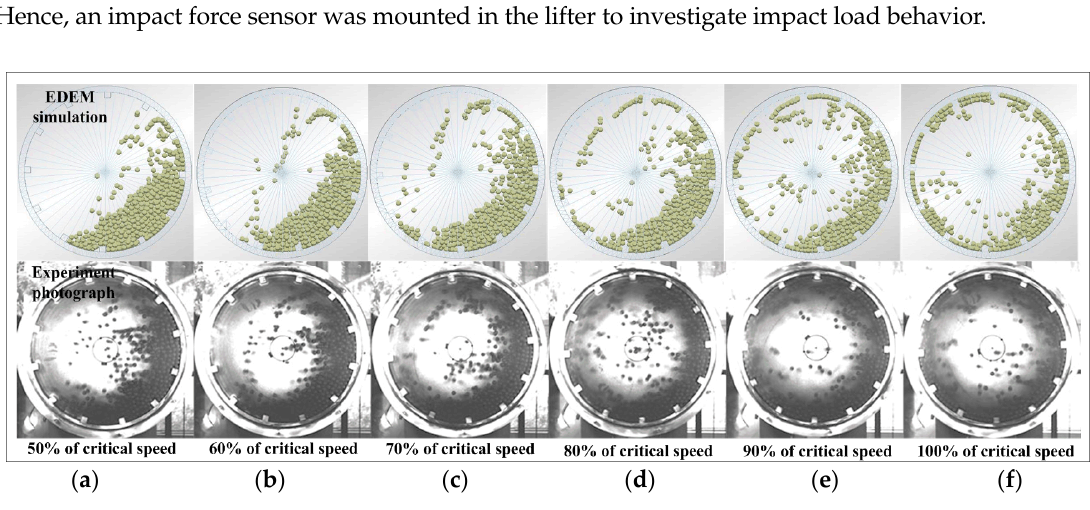
Figure 5. Photographs of the impact load behavior with a grinding media filling of 20% by volume at 50%–100% of critical speed: ( a ) 50%; ( b ) 60%; ( c ) 70%; ( d ) 80%; ( e ) 90%; and ( f ) 100%.